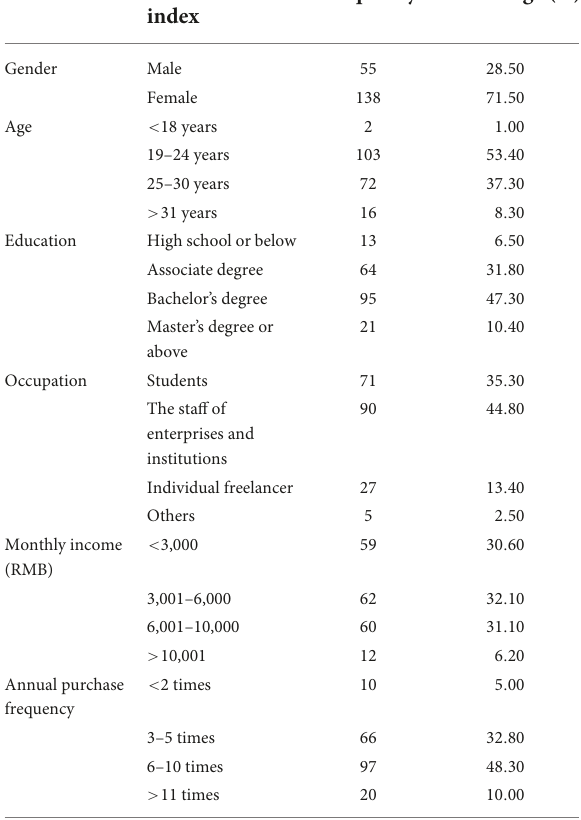
TABLE 2 Demographic characteristics of the